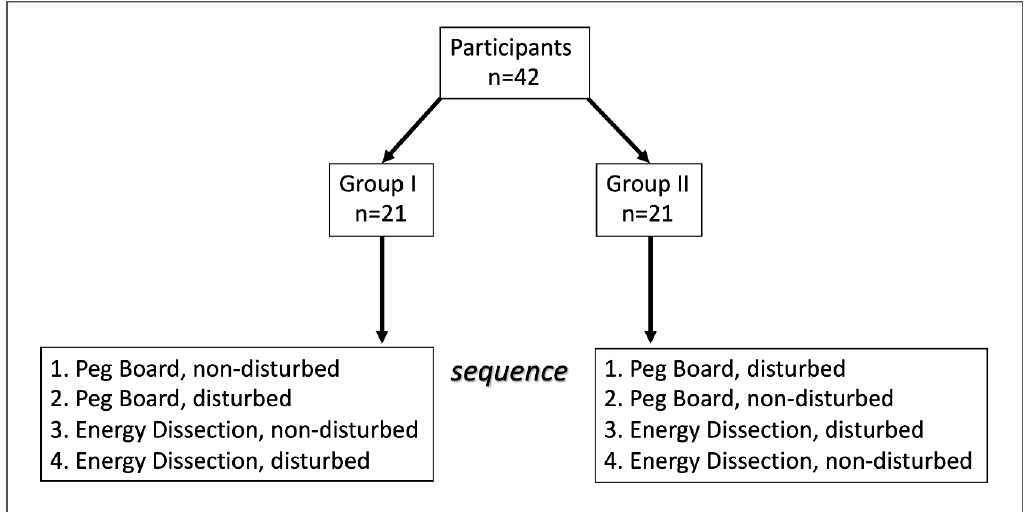
Figure 3. Test sequence. Figure 3. Test